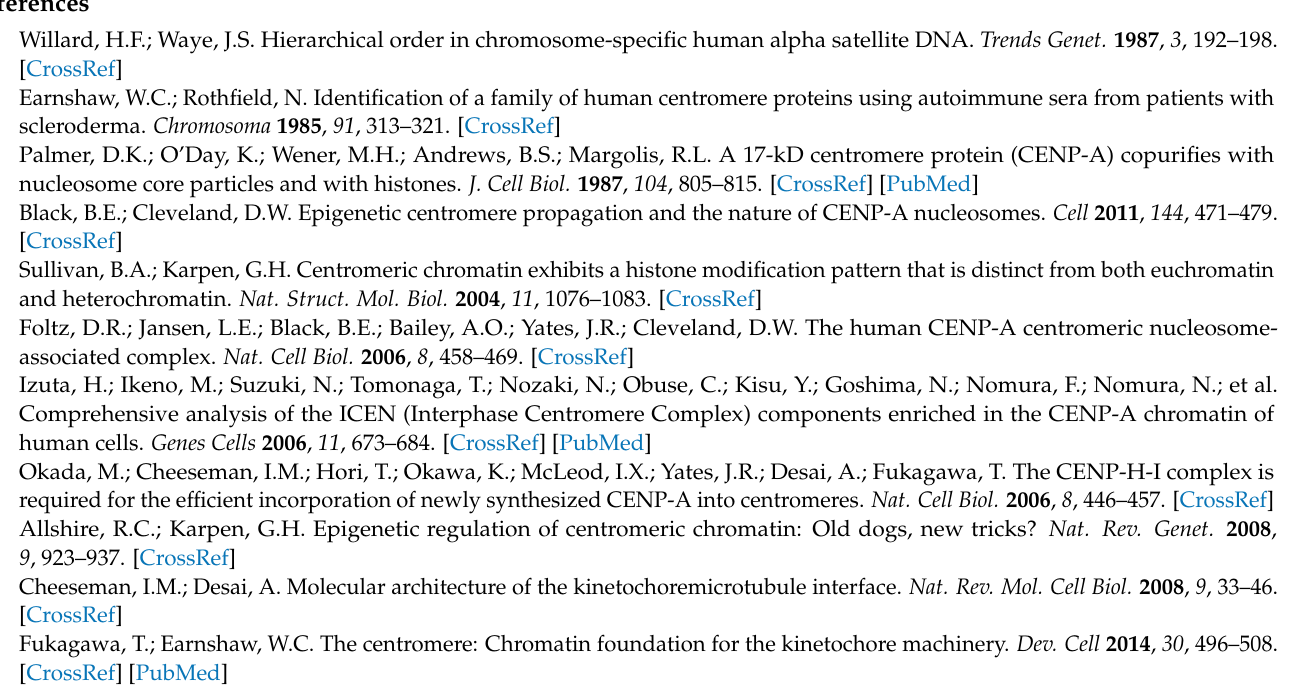
formation; Figure S2: Alignment of the nucleotide sequences of the synthetic alphoids ( Nhe I to Spe I); Figure S3: Effectiveness of protein tethering on the synthetic alphoid arrays; Figure S4: ChIP and competitive PCR analysis of the HAC chromatin structure using synthetic alphoid